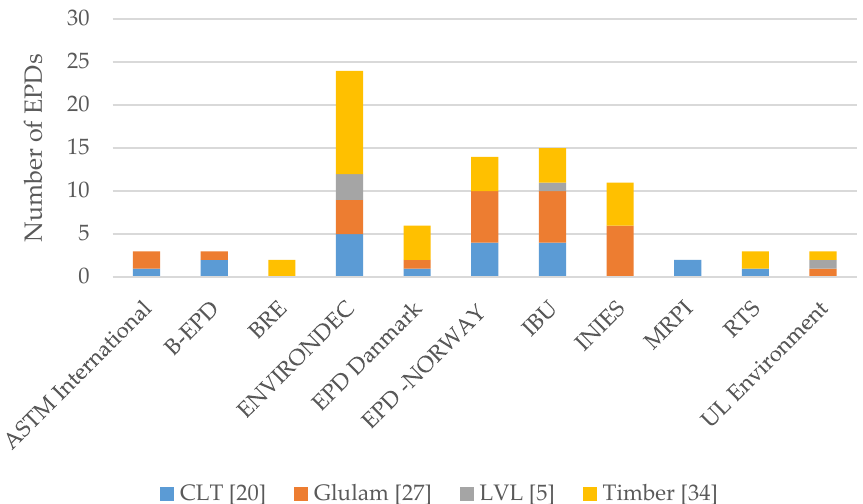
Figure 2. Total number of EN 15804 EPDs on structural wood products [in brackets], distributed on EPD program holders.